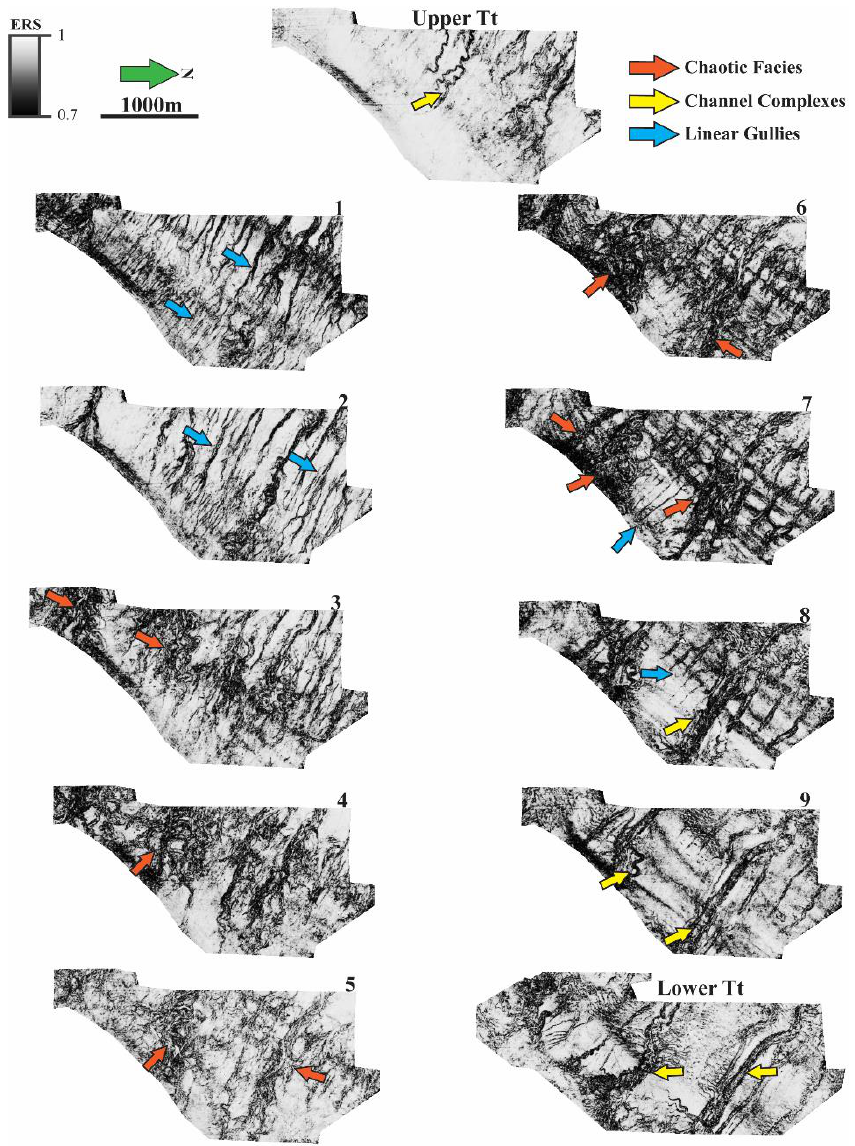
Figure 13. Pipeline-3D stratal slices draped with the ERS attribute. Channel complexes are typically characterized by low-sinuosity and minimal lateral migration. See Figure 4B for stratal slice location in cross section.